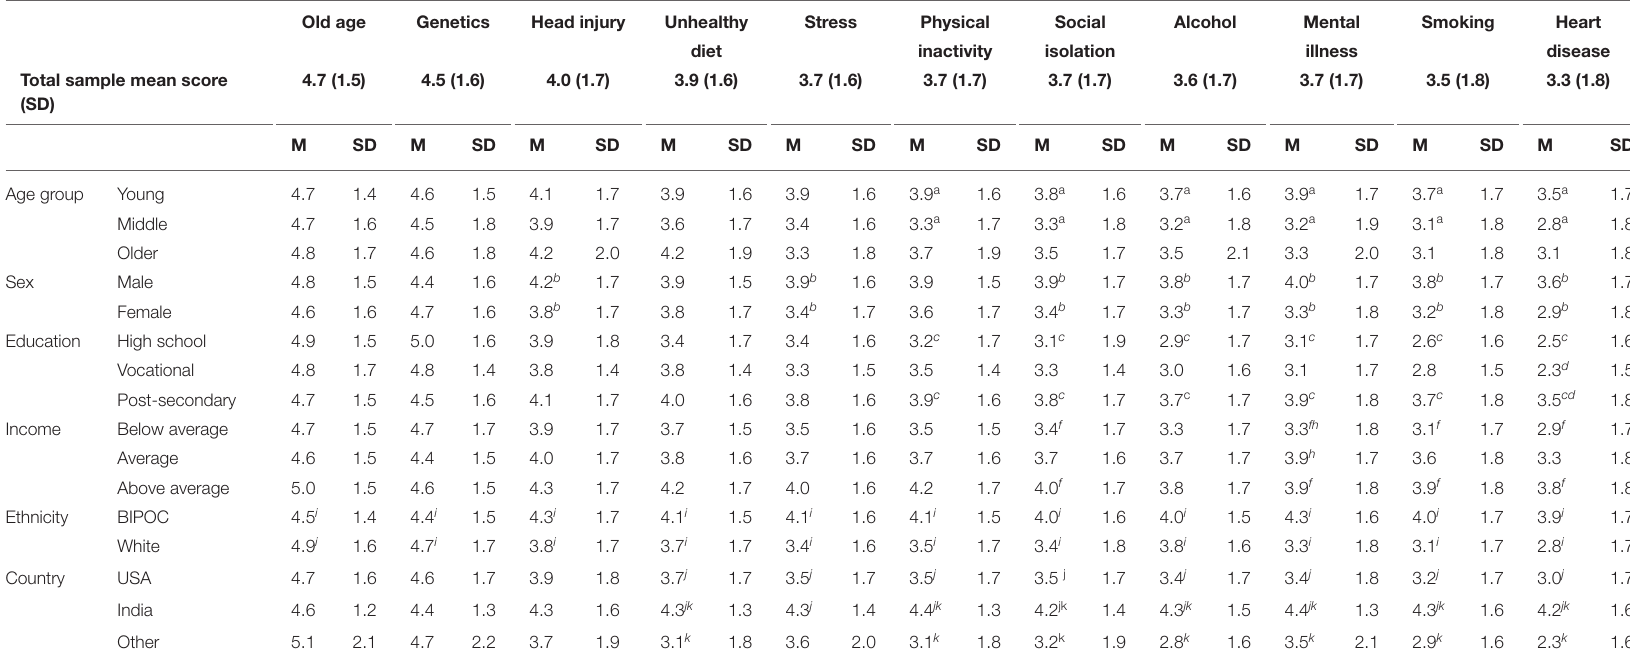
TABLE 4 | Mean and standard deviations per demographic variable for risk score of the 11 empirically supported risk factor for increasing dementia